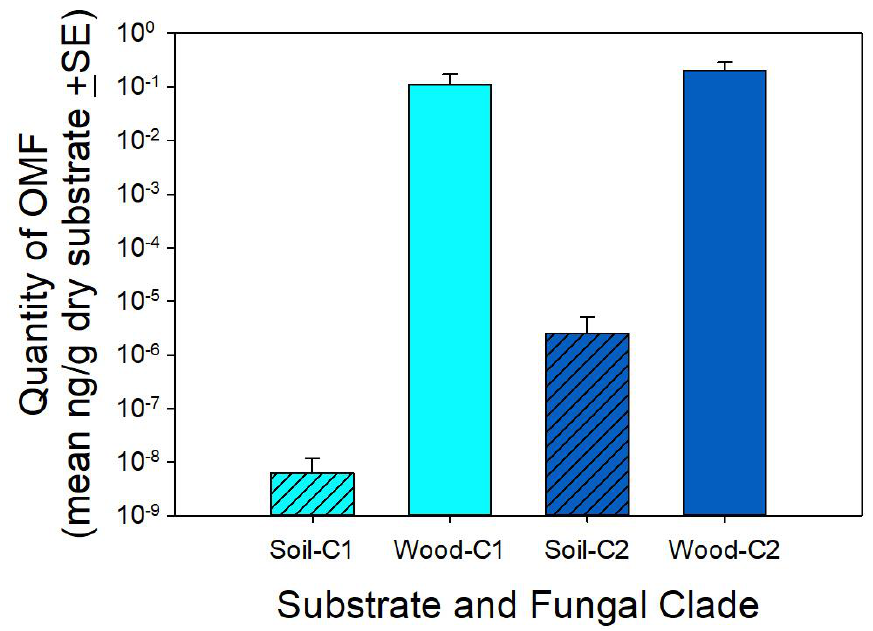
Figure 3. Abundance of the two clades of protocorm fungi in substrate rich in decomposing wood (solid bars) and soil (hatched bars) substrates. Clade 1 quantity is indicated by light blue bars and Clade 2 by dark blue bars. Note the log scale on the y-axis.